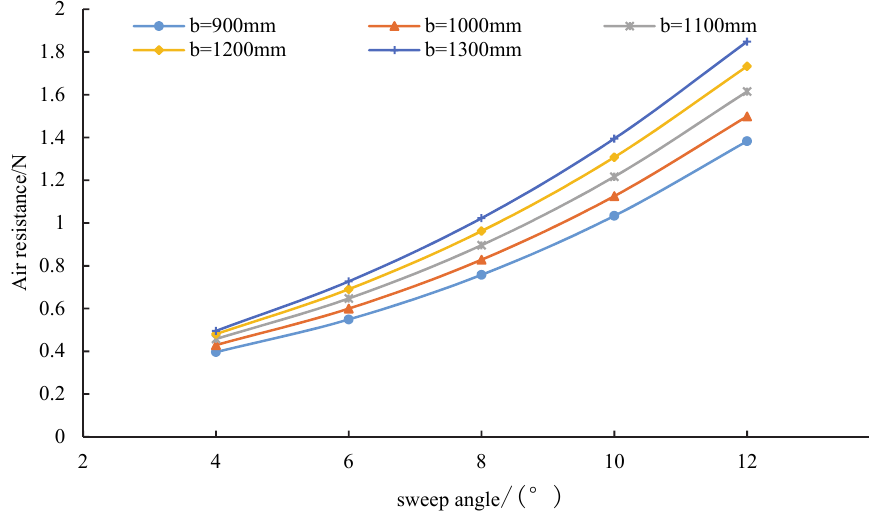
Figure 14. Variation of air resistance under di ff erent attack angles.